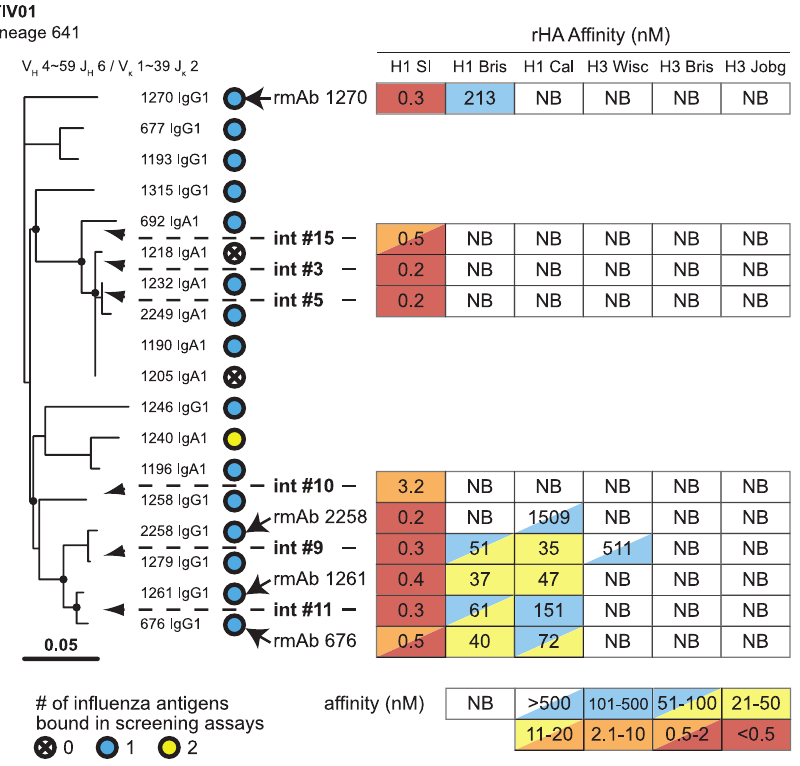
Figure 4. Clonal lineage 641 from TIV01. During screening, 15/18 rmAbs (83%) bound one influenza antigen (blue dots), 1/18 (6%) bound two antigens (yellow dot), 2/18 (11%) bound no antigen tested (crossed dots). Antibody 1270 bound rHA H1 SI with high affinity and H1 Bris with weak affinity. Two branches of the tree derived from IgA1-expressing plasma cells. Inferred intermediates (int) of one of these branches were consistent with affinity maturation (arrows pointing to circles on the tree indicate the position produced int rmAbs); int # 15 bound with lower affinity to H1 SI than later int # 3 or int # 5. Branches of the tree near the bottom showed breadth. Int # 10 bound only H1 SI; int # 9 had higher affinity for H1 SI, bound H1 Bris and H1 Cal with moderate affinity, and weakly bound H3 Wisc. Int # 11 bound H1 Cal more weakly and recovered rmAbs 676 and 1261 bound with a similar pattern. Recovered rmAb 2258 had the highest H1 SI affinity in this part of the lineage but lost cross-reactivity, retaining only weak reactivity to H1 Cal. Embedded tables show affinity measurements in nM for each rmAb; NB=no binding observed. H1 SI=H1N1 A/Solomon Islands/03/2006; H1 Bris=H1N1 A/Brisbane/59/2007; H1 Cal=H1N1 A/California/04/2009; H3 Wisc=H3N2 A/Wisconsin/67/2005; H3 Bris=H3N2 A/ Brisbane/10/2007; H3 Jobg=H3N2 A/Johannesburg/33/1994.